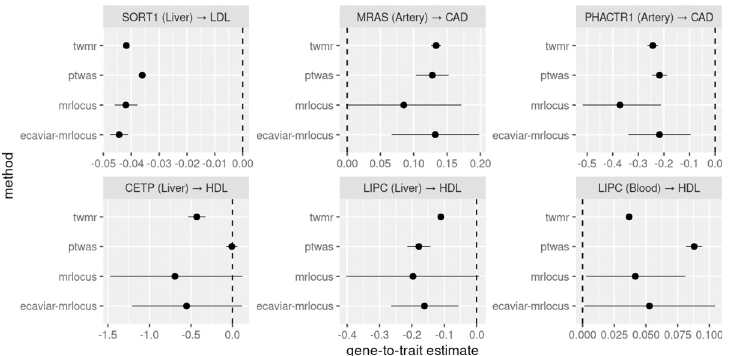
Fig 3. Estimated gene-to-trait effects for TWMR, PTWAS, and MRLocus on five eQTL and GWAS datasets for strong candidate genes for mediation of the GWAS trait and one auxiliary tissue example ( LIPC in blood). 80% confidence or credible intervals are shown (MRLocus provides quantile-based credible intervals). The artery eQTL were estimated from inverse normal transformed expression data from GTEx, transformed z-scores for eQTLGen, while the liver meta-analysis eQTL were estimated from log2 expression data, thus the estimated slopes represent changes in SD of artery or blood gene expression on log odds for CAD risk and on SDs of lipid levels, and doubling of liver gene expression on SDs of lipid